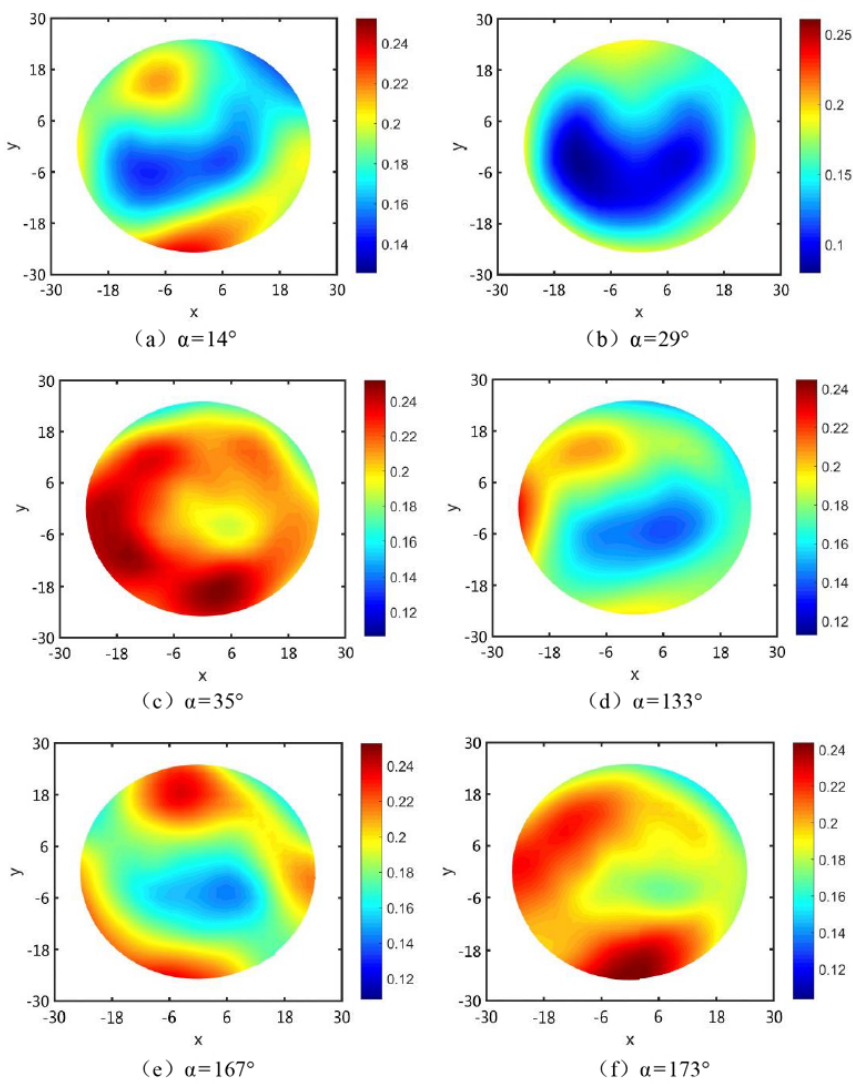
Figure 5. Pressure simulation of different FAPs.